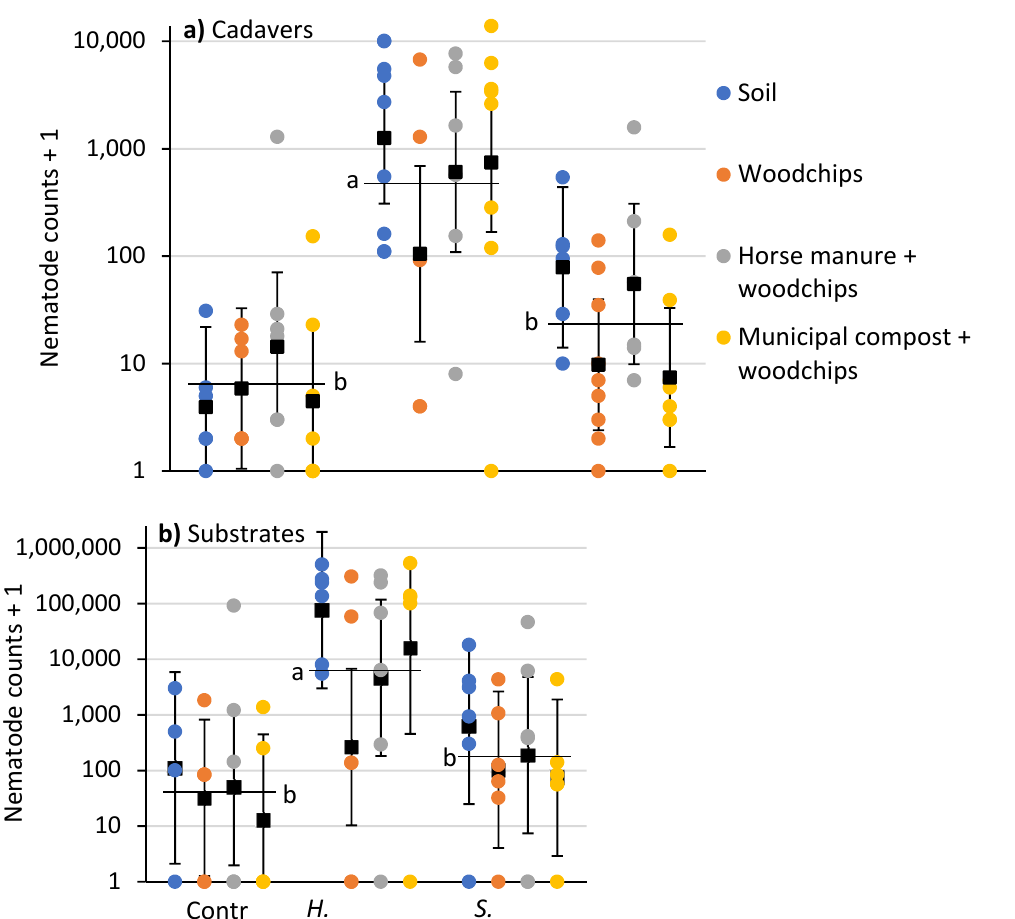
Figure 2. Counts (colored circles) and means ( ± 95% CI) (black squares) of nematodes recovered in white traps from ( a ) P. japonica cadavers and ( b ) soil samples beneath substrates 10 days after aqueous preparations (40 mL) of Heterorhabditis bacteriophora or Steinernema scarabaei (50 infective juveniles/cm 2 ) were added to soil, woodchips, horse manure and woodchips or municipal compost and woodchips in plastic containers (1 L). Entomopathogenic nematode species means (horizontal black lines) with the same letter are not significantly different in each panel (Tukey’s HSD test, α = 0.05).